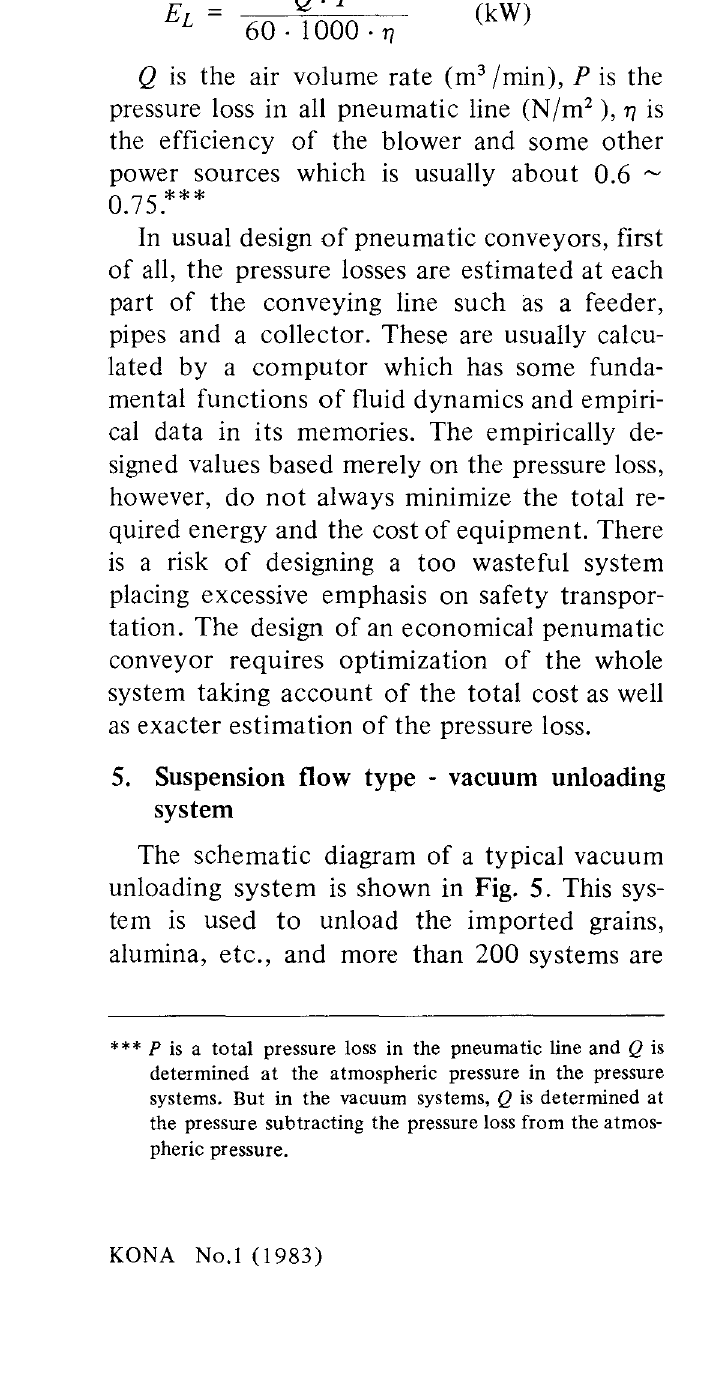
Fig. 5 Typical ship unloading system with a telescopic pipe